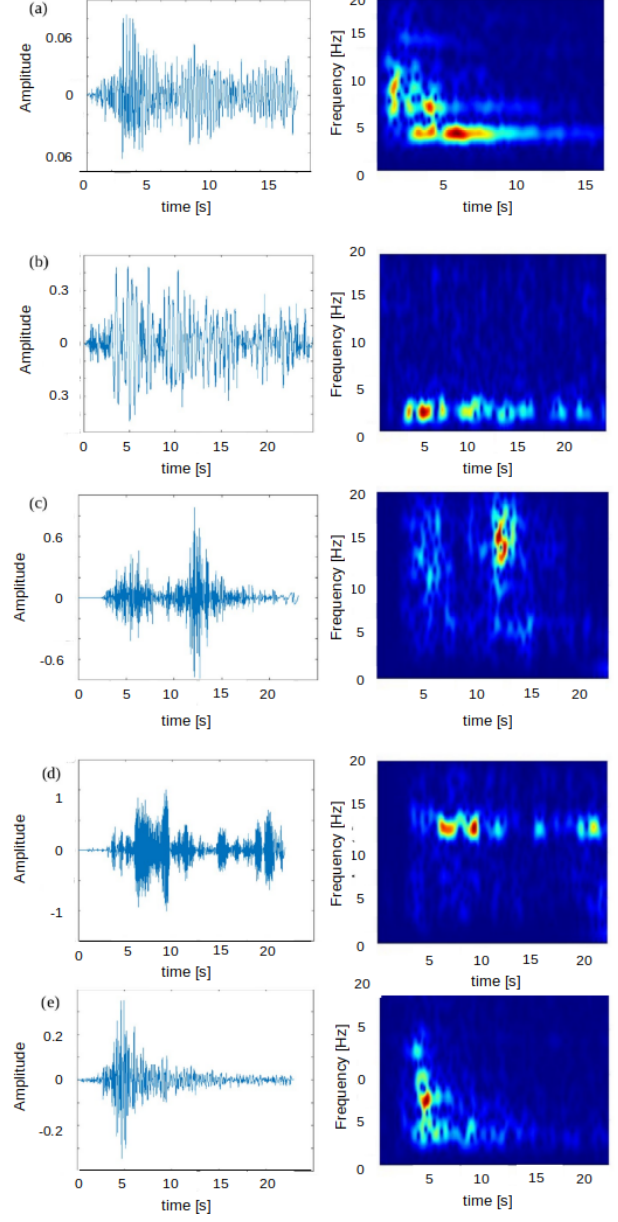
Figure 4. Examples of time series (left) and spectrograms (right) for the different classes in the Lascar database: (a) hybrid events (HY), (b) long period (LP), (c) tectonic events (TC), (d) tremors (TR), and (e) volcano–tectonic